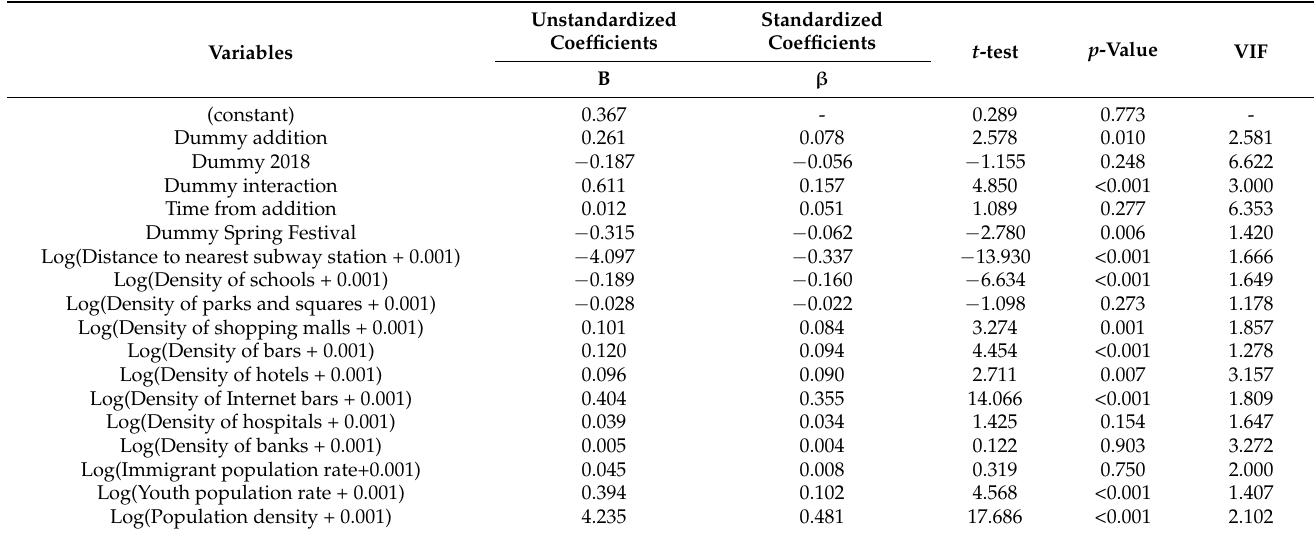
Table 4. Results of difference-in-differences